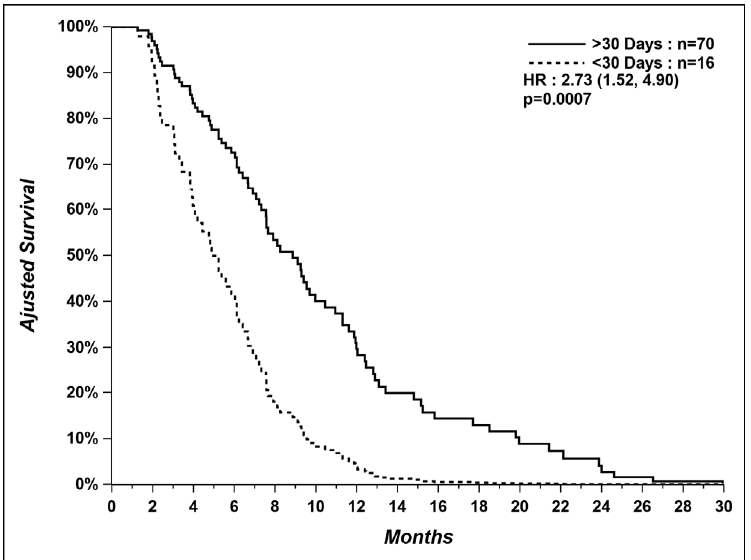
Figure 3. Overall survival of patients who received systemic therapy within last 30 days versus patients who did not, after excluding patients with unexpected and unknown causes of death.